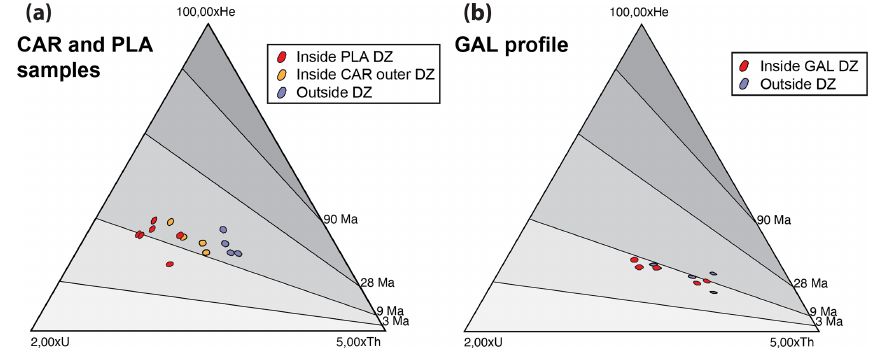
Figure 12. U–Th–He diagrams using Helioplot (Vermeesch, 2010) for (a) CAR and PLA samples (this study and Milesi et al., 2019) as well as (b) GAL profile samples (no hot springs).